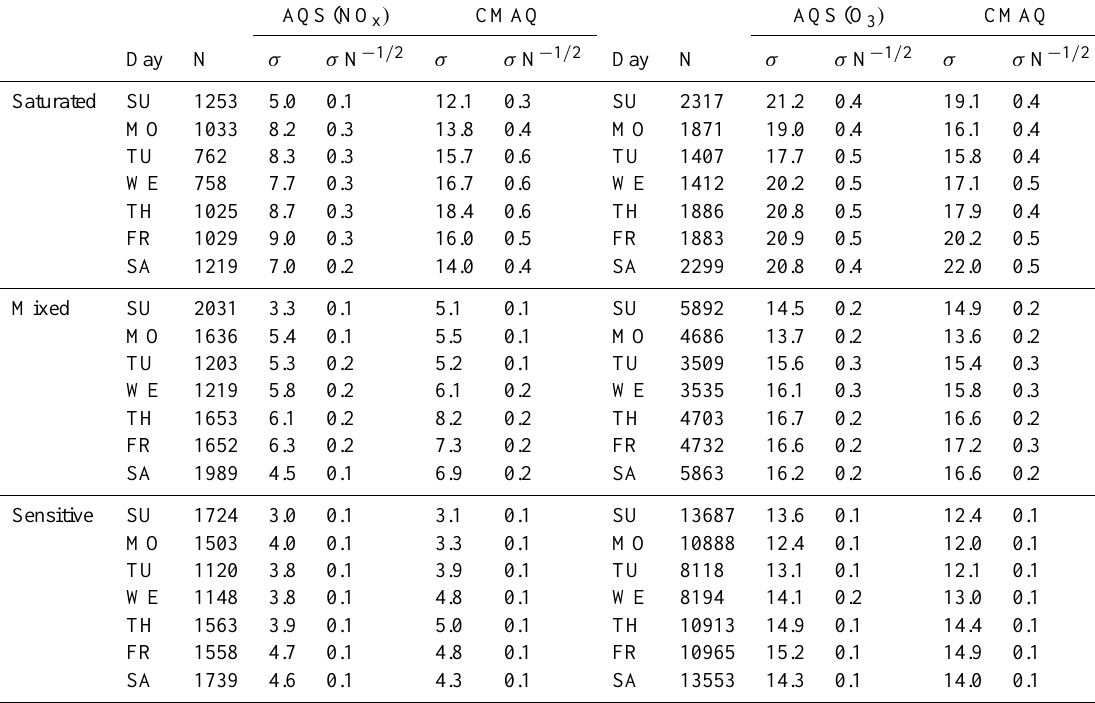
Table 4. The number of data (weekly anomaly), the standard deviation, and the standard error of the mean (SEM) of EPA AQS observations and CMAQ simulations for NO x and O 3 measurement sites over the CMAQ-derived chemical regimes. AQS (NO x )